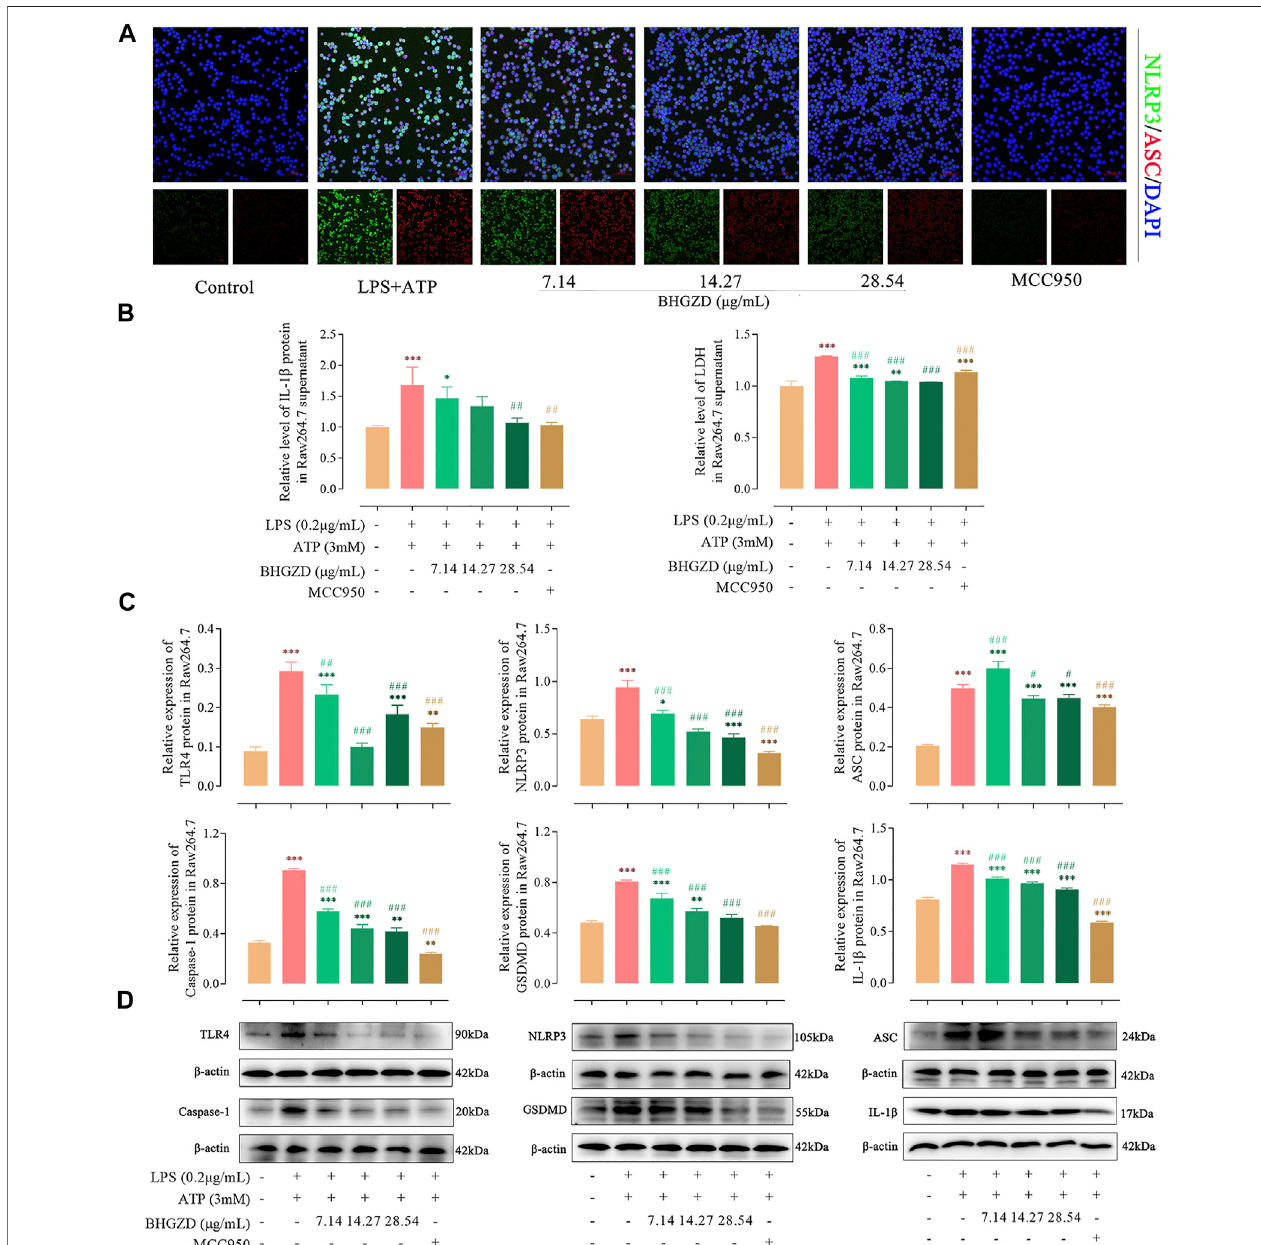
FIGURE4 | InhibitoryeffectsofBHGZDontheTLR4 – mediatedNLRP3in fl ammasomeactivationinLPS/ATP – inducedRaw264.7macrophagecells. (A) Theexpressionof NLRP3andASCproteinswasmeasuredbyimmuno fl uorescencestainingandconfocalmicroscopyinRaw264.7macrophagecells(NLRP3FITCgreen,ASCCY3red,DAPIblue; scalebarrepresents50 μ m). (B) ThesecretionofIL-1 β andLDHreleaseinRaw264.7macrophagecellswereevaluatedbyELISA. (C ∼ D) TheexpressionlevelsofTLR4,NLRP3, ASC, caspase-1, GSDMD, and IL-1 β in Raw264.7 macrophage cells were measured by Western blotting. *, **, and ***, p < 0.05, p < 0.01, and p < 0.001, respectively, in comparison with the normal control group; #, ##, and ###, p < 0.05, p < 0.01, and p < 0.001, respectively, in comparison with LPS/ATP – induced model.